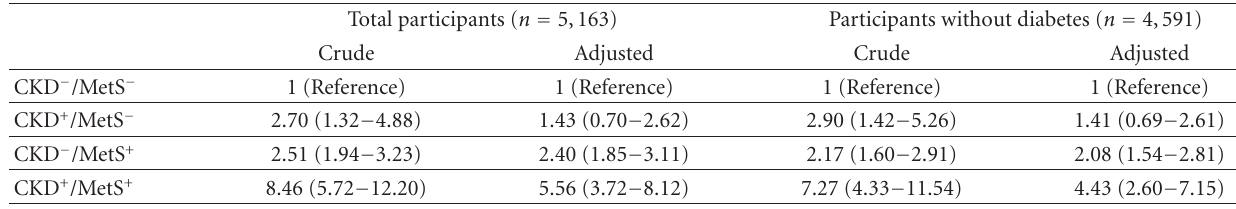
Table 2: Unadjusted and multivariate-adjusted HRs of CVD events associated with CKD and